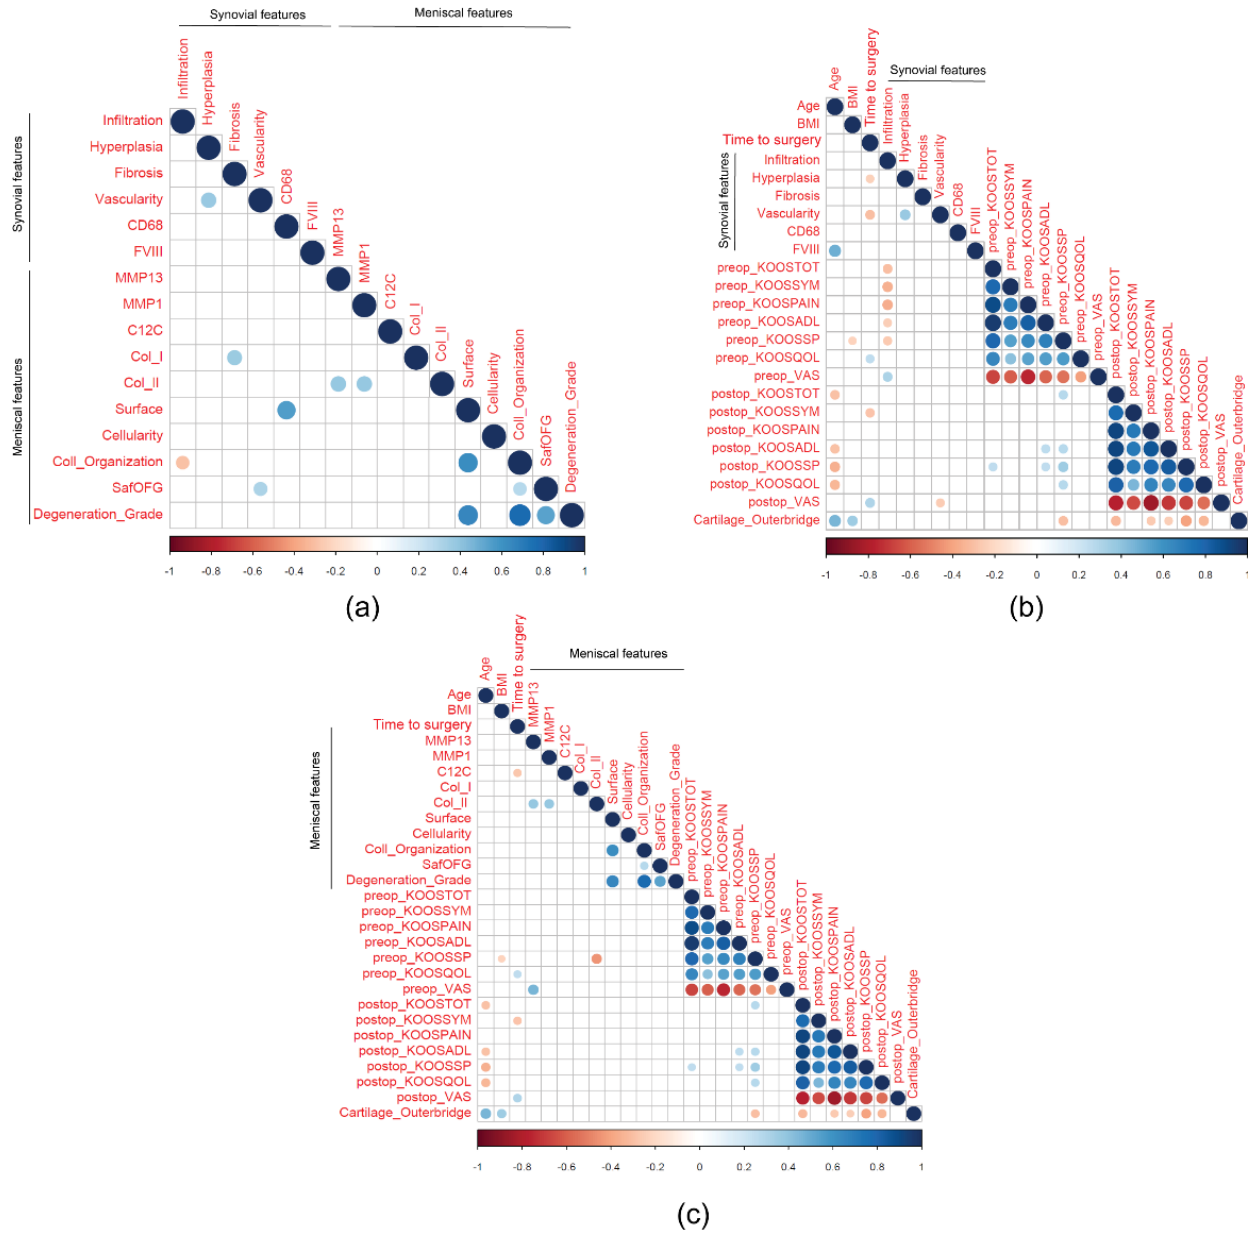
Figure 7. Correlations between tissues and clinical data. ( a ) Correlations between synovial and meniscal tissues; ( b ) Correlations between synovial features and clinical data; ( c ) Correlations between meniscal and clinical data. Negative correlations are displayed in red, while positive correlations are in blue. Color intensity and size of the circle are proportional to the correlation